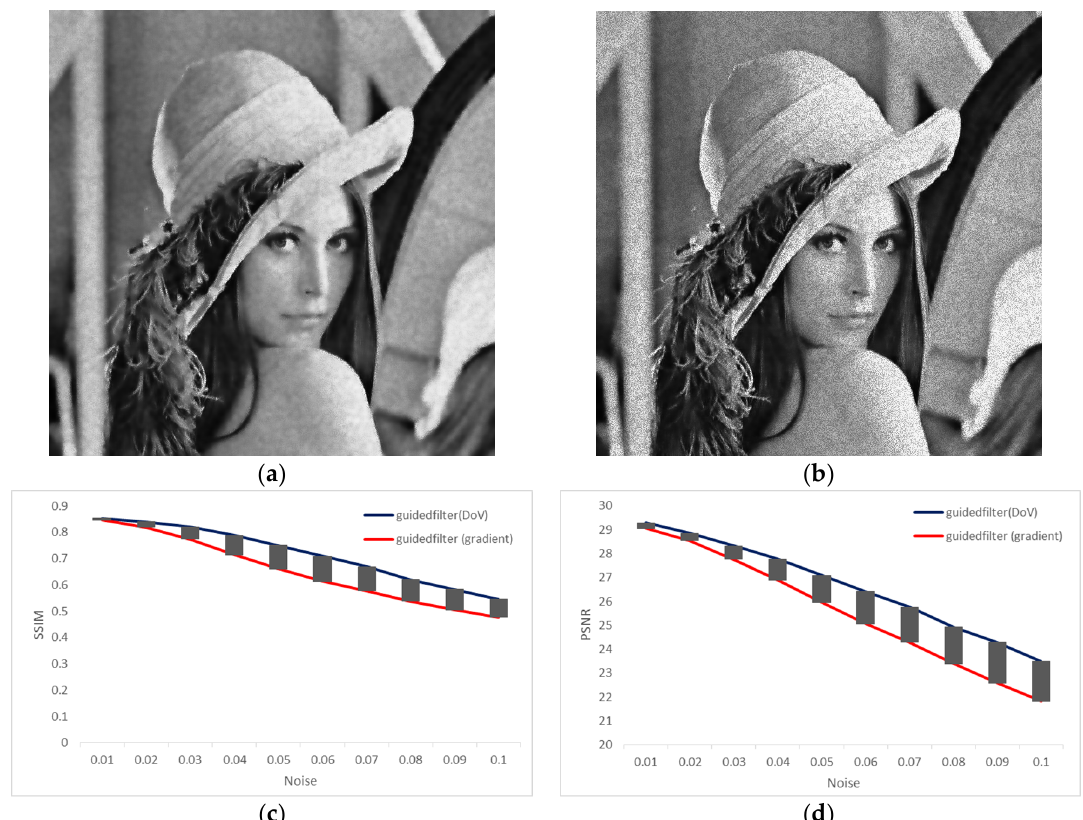
Figure 6. Comparisons of the EGF performance and GF performance. ( a ) the result of EGF on noisy image; ( b ) the result of GF on noisy image; ( c ) Comparison of SSIM values for denoised image by EGF and SSIM values for denoised image by GF; ( d ) Comparison of PSNR values for denoised image by EGF and SSIM values for denoised image by GF.